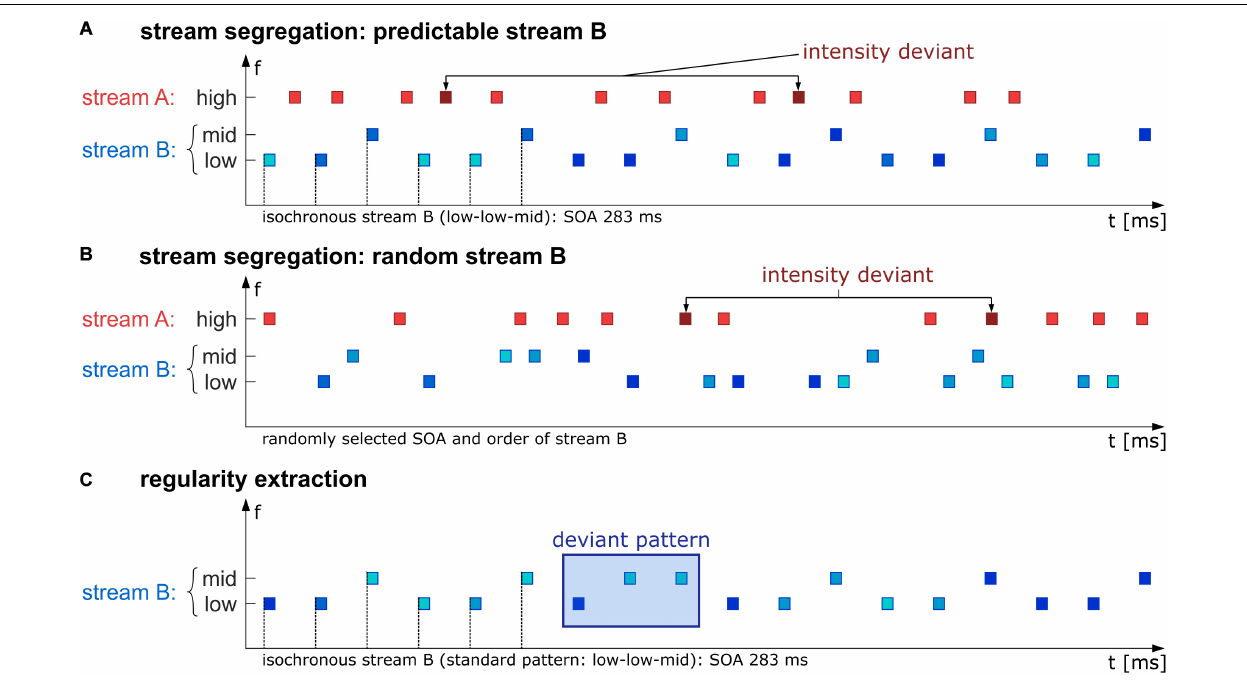
FIGURE 1 | Schematic illustration of the stimulus paradigm. In the first experimental part, participants were instructed to detect intensity deviants (probability in sequence 10%, deviants are 10 dB higher in level than standards) in a high-frequency stream A (red rectangles). The task-irrelevant stream B (blue rectangles) was presented in either an isochronous (SOA 283 ms) and therefore predictable low-low-mid pattern (A) or random in the chosen SOA (160, 270, or 420 ms) and frequency (either low or mid, B ). The second experimental part was a passive listening condition in which just the B stream was presented (isochronous, SOA 283 ms) containing standard low-low-mid triplets which were rarely interrupted by a deviant low-mid-mid triplet with probability of 17% (C) . SPL levels in stream B across all conditions (A–C) varied between 55 and 75 dB illustrated by different blue